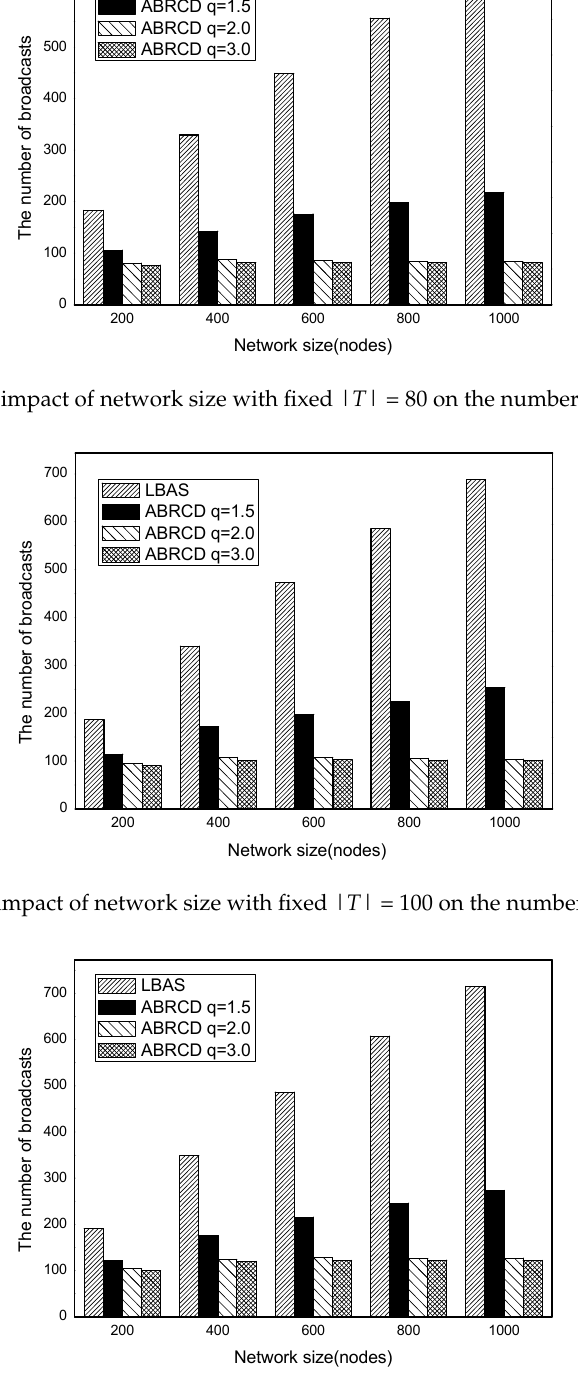
Figure 37. The impact of network size with fixed | T | = 120 on the number of broadcasts.